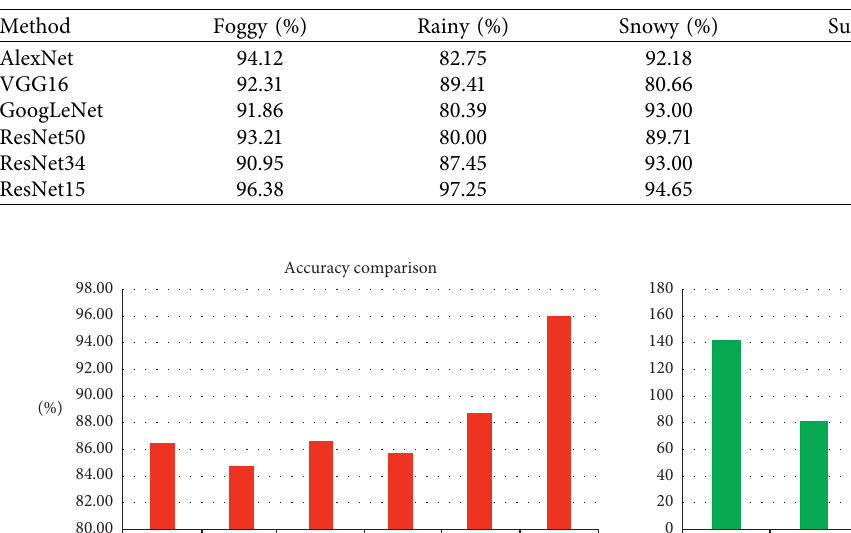
Table 4: Recognition accuracy of different methods.